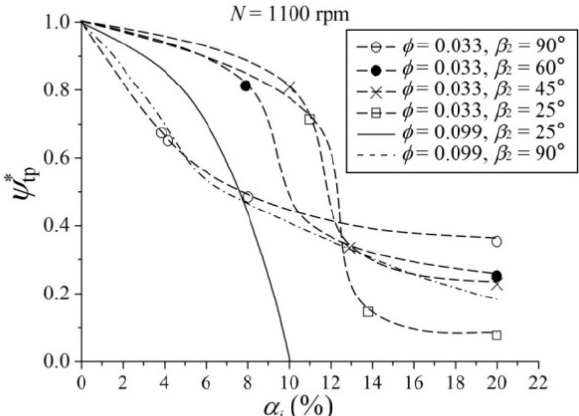
Figure 11. Effects of outlet blade angle on the evolution of performance degradation ratio versus inlet void fraction (extracted from Sato et al. [23]).